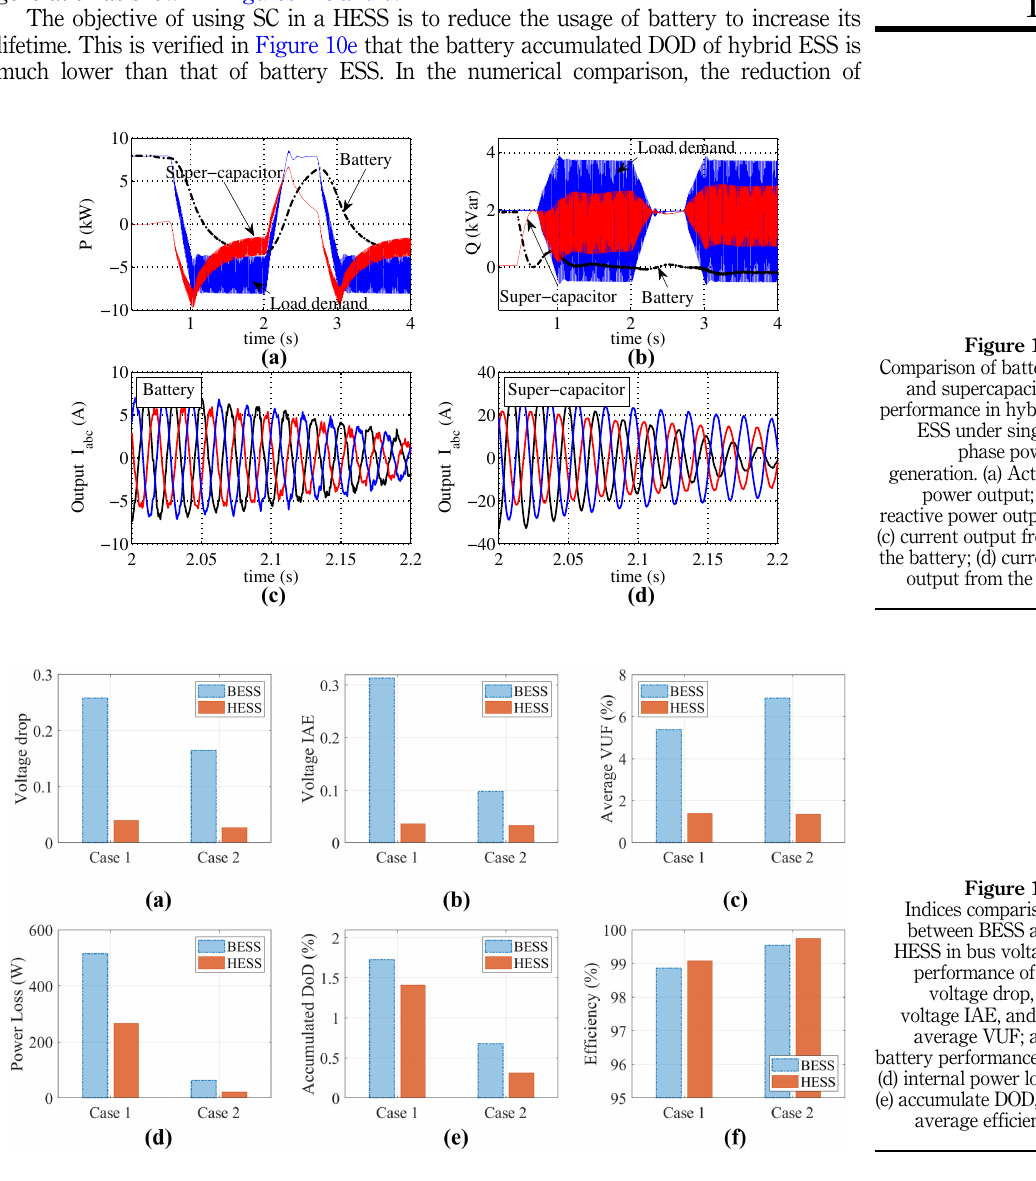
Figure 12. Indices comparison between BESS and HESS in bus voltage performance of (a) voltage drop, (b) voltage IAE, and (c) average VUF; and battery performance of (d) internal power loss, (e) accumulate DOD, (f) average